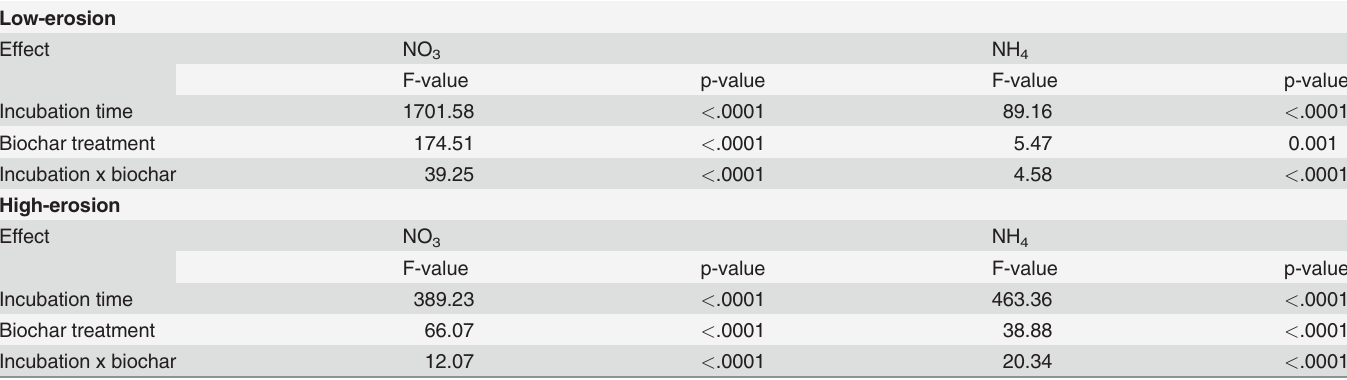
Table 4. Analysis of Variance results of the generalized linear mixed models for the incubated high-erosion and low-erosion